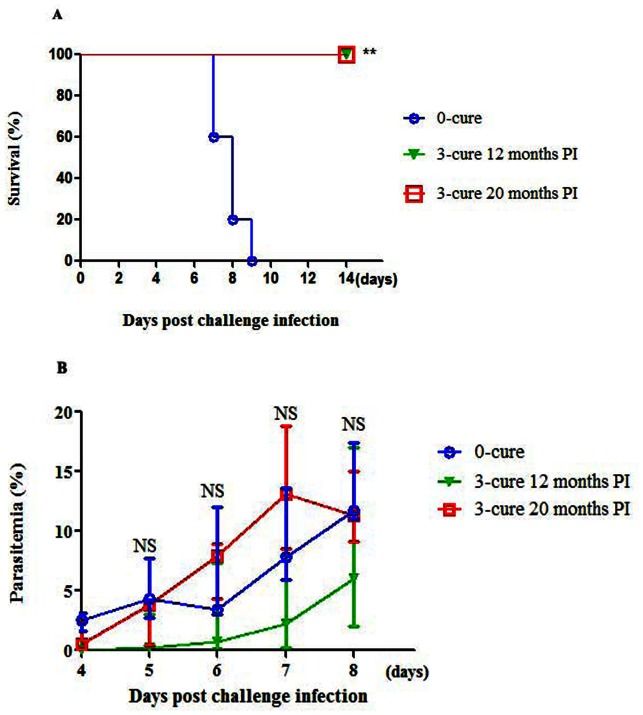
Long-lived resistance against ECM in 3-cure mice.After challenge infection, 3-cure mice fully recovered with clearance of parasitemia around day 21 PI. They were regularly examined at 3-month intervals and showed no parasitemia. Twelve and twenty months post the last challenge infection, these aged 3-cure mice were re-challenged with 104 of homologous PbA-pRBCs. The age-matched B6 mice were used as control. (A) Survival curves and (B) Parasitemia profile. Data presented are from one experiment with three to five mice in each group. Statistic significance between 0-cure and 3-cure was performed by using log-rank test and Mann-Whitney U test, where NS, p>0.05; **, p<0.01.